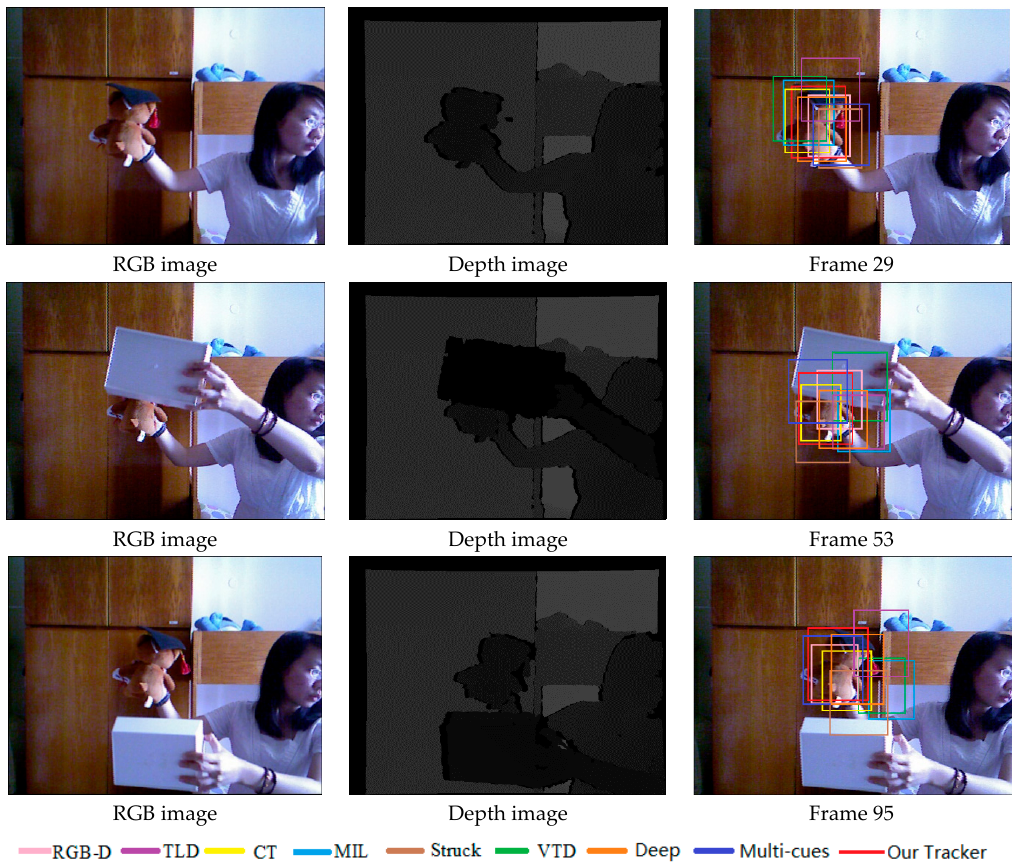
Figure 7. The tracking results on the test video 1 obtained by different methods.